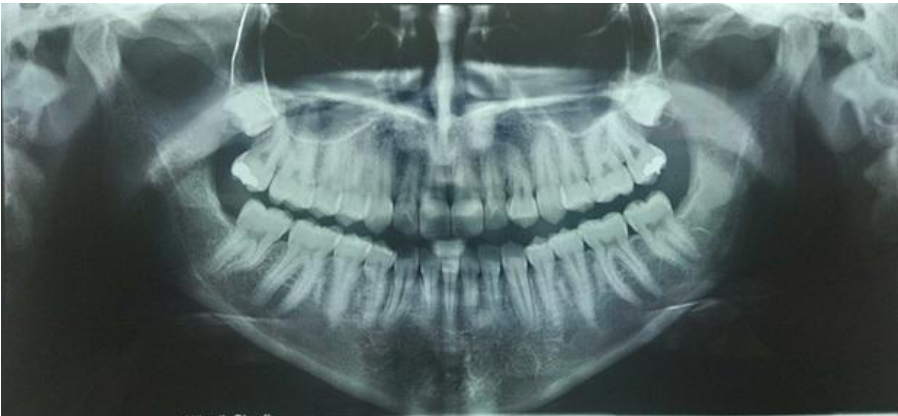
Figure 10. The panoramic radiograph of the patient after eleven years follow-up at the age of